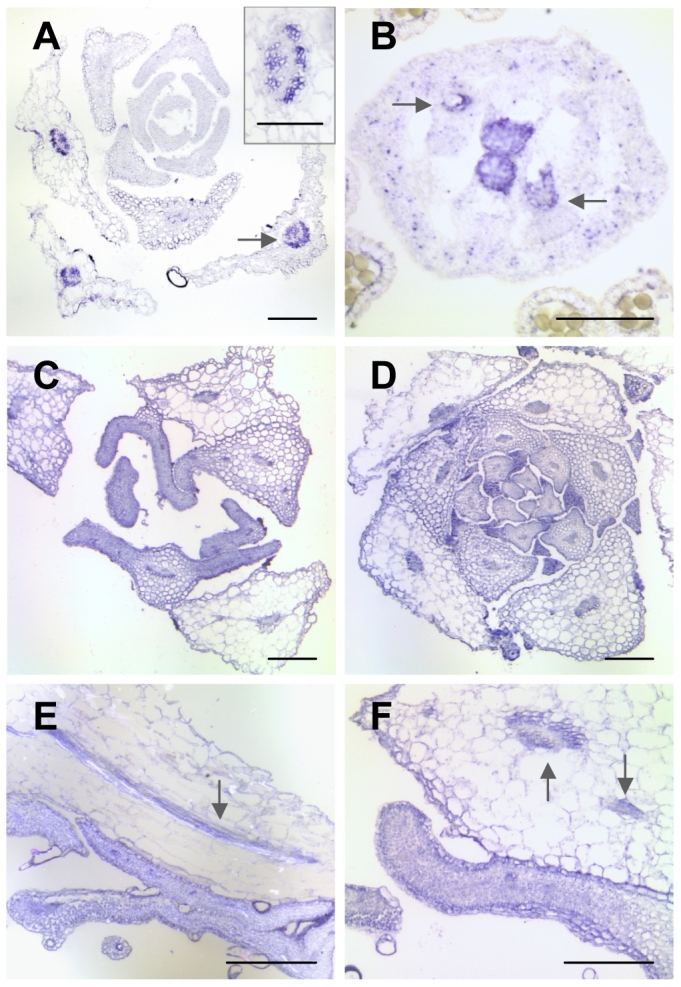
Expression pattern of DAISY in the lcr, bdg, and wild-type plants.The tissue-specific localization of DAISY mRNA was revealed by in situ hybridization using the antisense riboprobe. (A) Cross-section showing expression in the wild type rosette. Arrow indicates an in situ hybridization signal in a vascular bundle of developing leaves. The upper right insert shows a magnified view of a vascular bundle. (B) Cross-section through the stylar tissue of a wild-type pistil, revealing the expression signal in the pollen transmitting tract and ovules (arrows). (C) Cross-section of the lcr rosette. (D) Cross-section of the bdg rosette. Note that DAISY is ectopically induced in young developing leaves. (E) Semi-longitudinal section showing fusions between younger and older leaves in lcr. Arrow depicts signals in the vasculature of the older leaf. (F) Cross-section through fusions between younger and older leaves in bdg. Arrows depict signals in the vasculature of the older leaf. Note that the hybridization signal (E) and (F) in the younger leaves is comparable to that in the vascular bundles (arrows), and it may be somewhat stronger in the epidermis than in the inner tissues. Bars are 200 µm for (A,C,D,E,F), and 100 µm for (B) and the insert in (A).